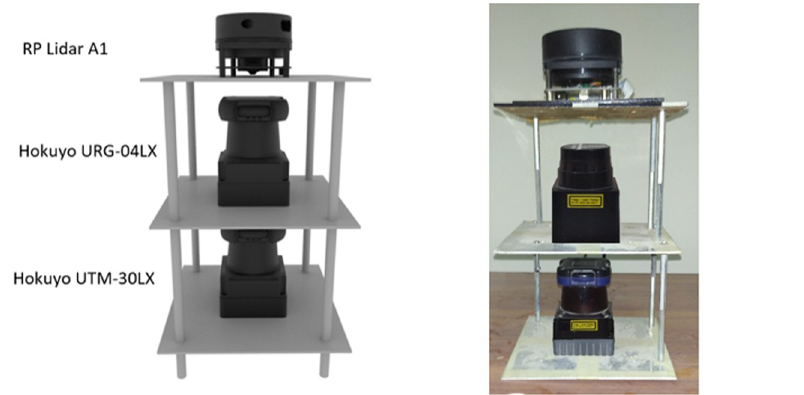
Fig 2. Experimental setup (left) 3D CAD model (right) real hardware.